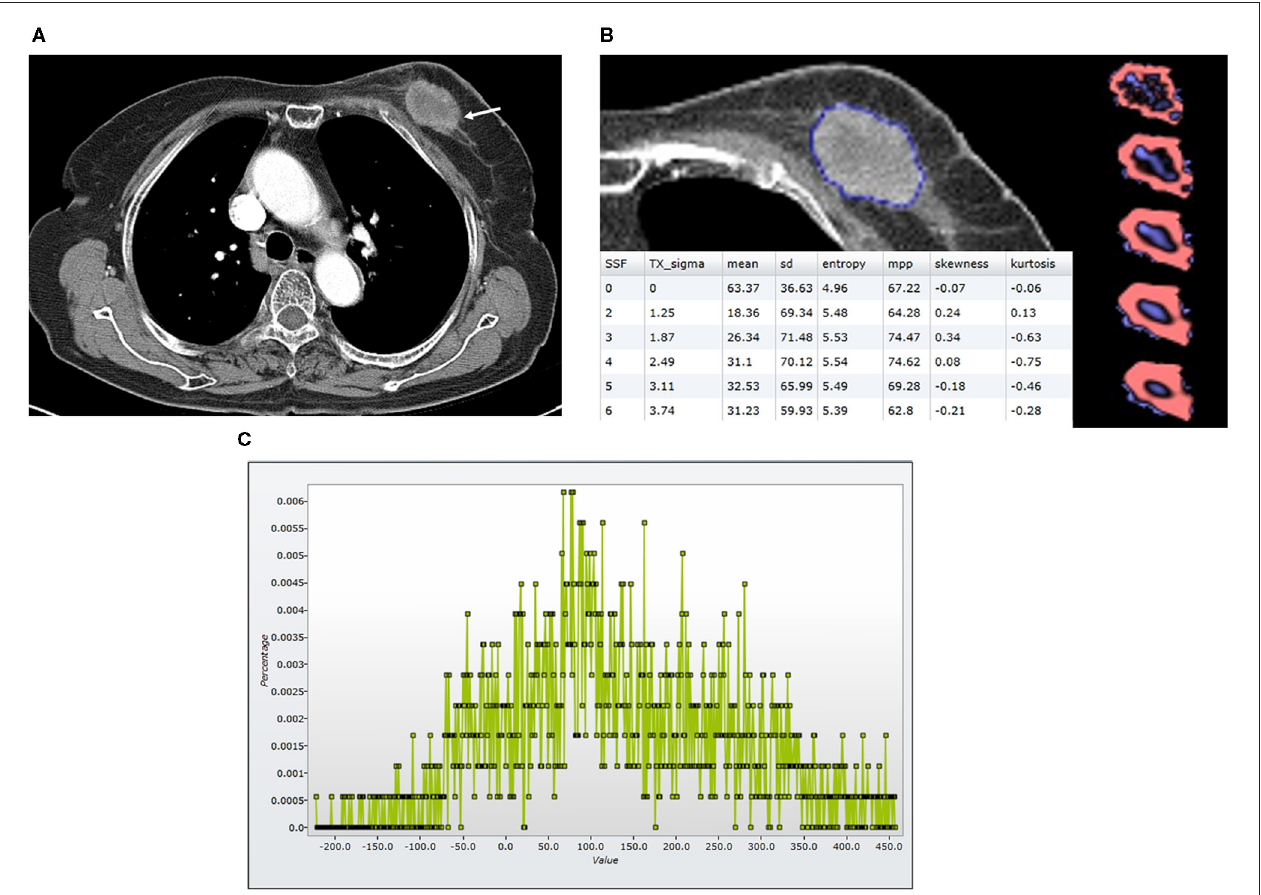
FIGURE 2 | Findings in a 74-year-old woman who died 23 months after the diagnosis of luminal-like breast cancer in the left breast. At the time of diagnosis, she did not have a distant metastasis. (A) An axial post-contrast CT image shows an irregular enhancing mass (arrow) with a central area of low attenuation, suggesting necrosis. (B) A texture analysis image shows a region of interest (blue line), texture maps, and texture parameters on the CT image. (C) A CT texture histogram is obtained; from which, the different statistical-based metrics are extracted. Mean, MPP, entropy, and SD were lower for the patient with poor a prognosis. MPP, mean of positive pixels; SD, standard